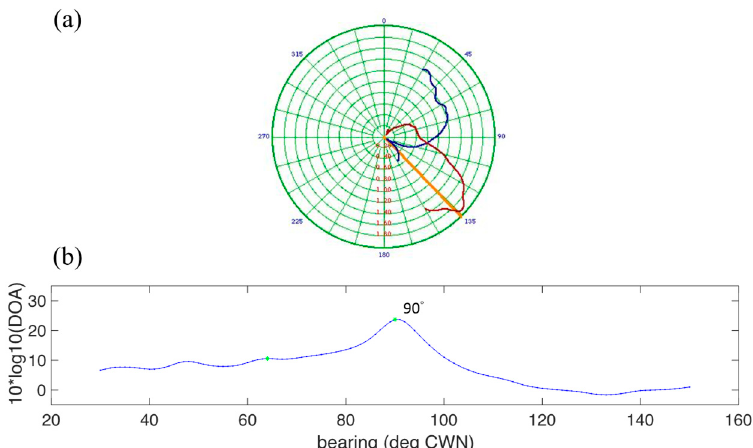
Figure 8. Schematics of the measured antenna pattern and DOA function: ( a ) The red and blue lines are two cross-loop antenna patterns; the orange line is the loop 1 pointing angle; ( b ) DOA function;